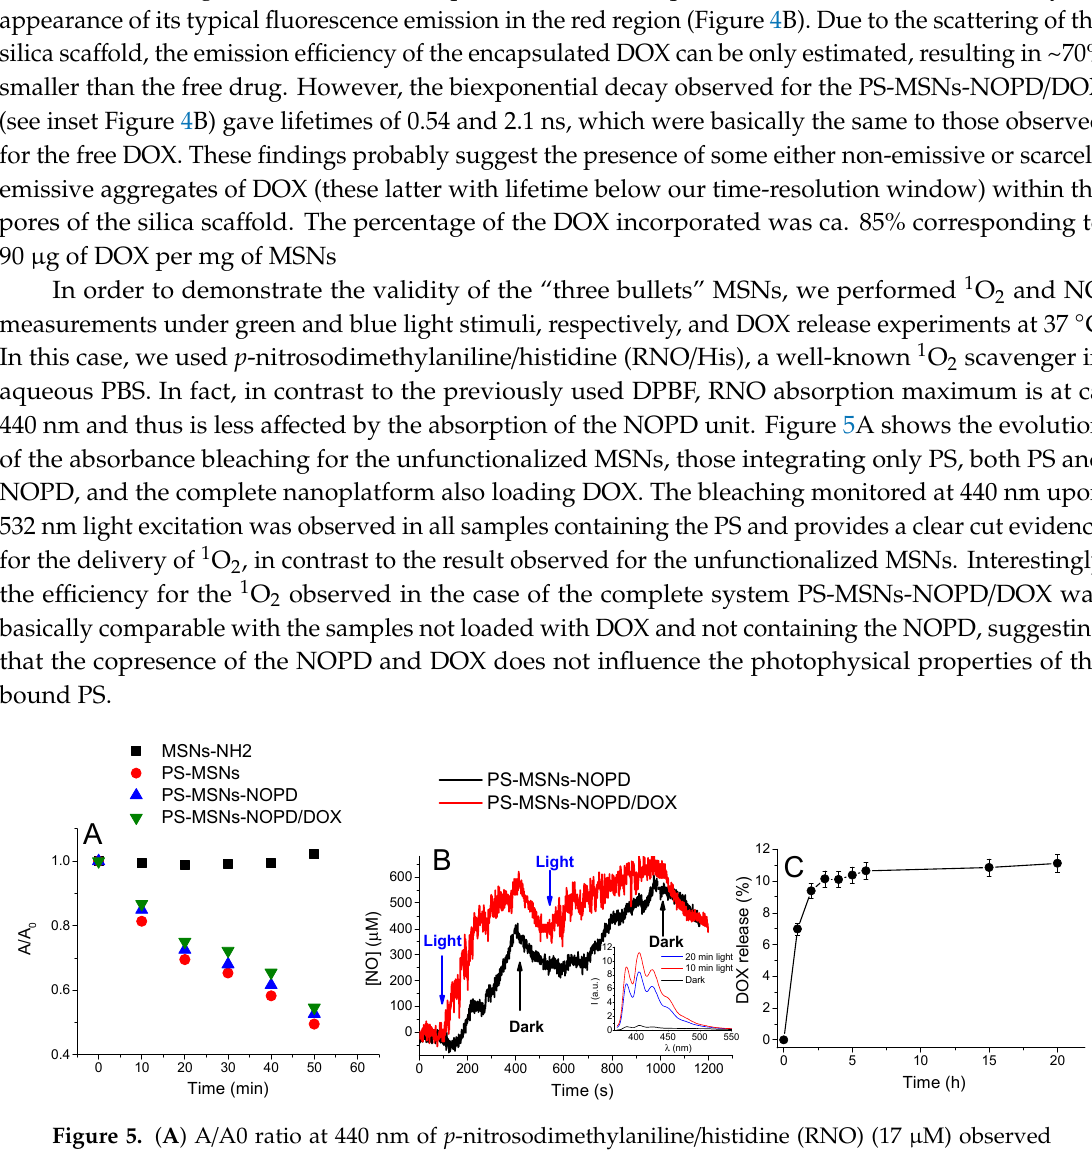
Figure 6. Representative histograms of Pgp/ABCB1, MRP1/ABCC1, and BCRP/ABCG2 surface levels in A375 cells, measured by flow cytometry in duplicate. The figure is representative of 1 out of 3 experiments with similar results. Thanks to the logical design of the MSNs, irradiation with blue light permits the selective excitation of the NOPD component, ruling out any participation of 1 O 2 (which would require green light excitation of the PS) in the cell viability. Figure 7 shows that the different samples of MSNs are well tolerated in the dark and that only a slight toxicity was observed upon blue light irradiation. Moreover, the very moderate phototoxicity observed in the sample with NOPD (PS-MSNs-NOPD) is basically the same to that of the sample, which does not integrate the NOPD (PS-MSNs/DOX), suggesting that under these experimental conditions NO is produced at not toxic doses. Interestingly, irradiation of the whole nanoconstruct (PS-MSNs-NOPD/DOX) increases cytotoxicity. PS-MSNs-NOPD/DOX reduced cell viability more than PS-MSNs-NOPD and PS-